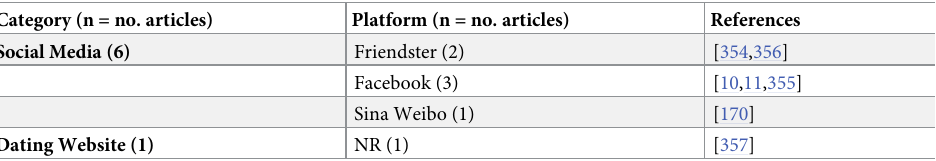
Table 9. Number of articles predicting sexual orientation, with associated platforms and